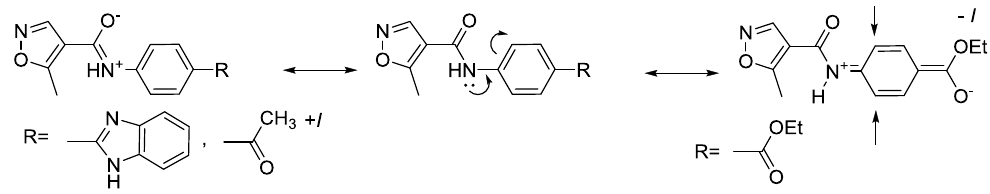
Figure 2. Effect of conjugation and para-substitution on the barrier or rotamer population.